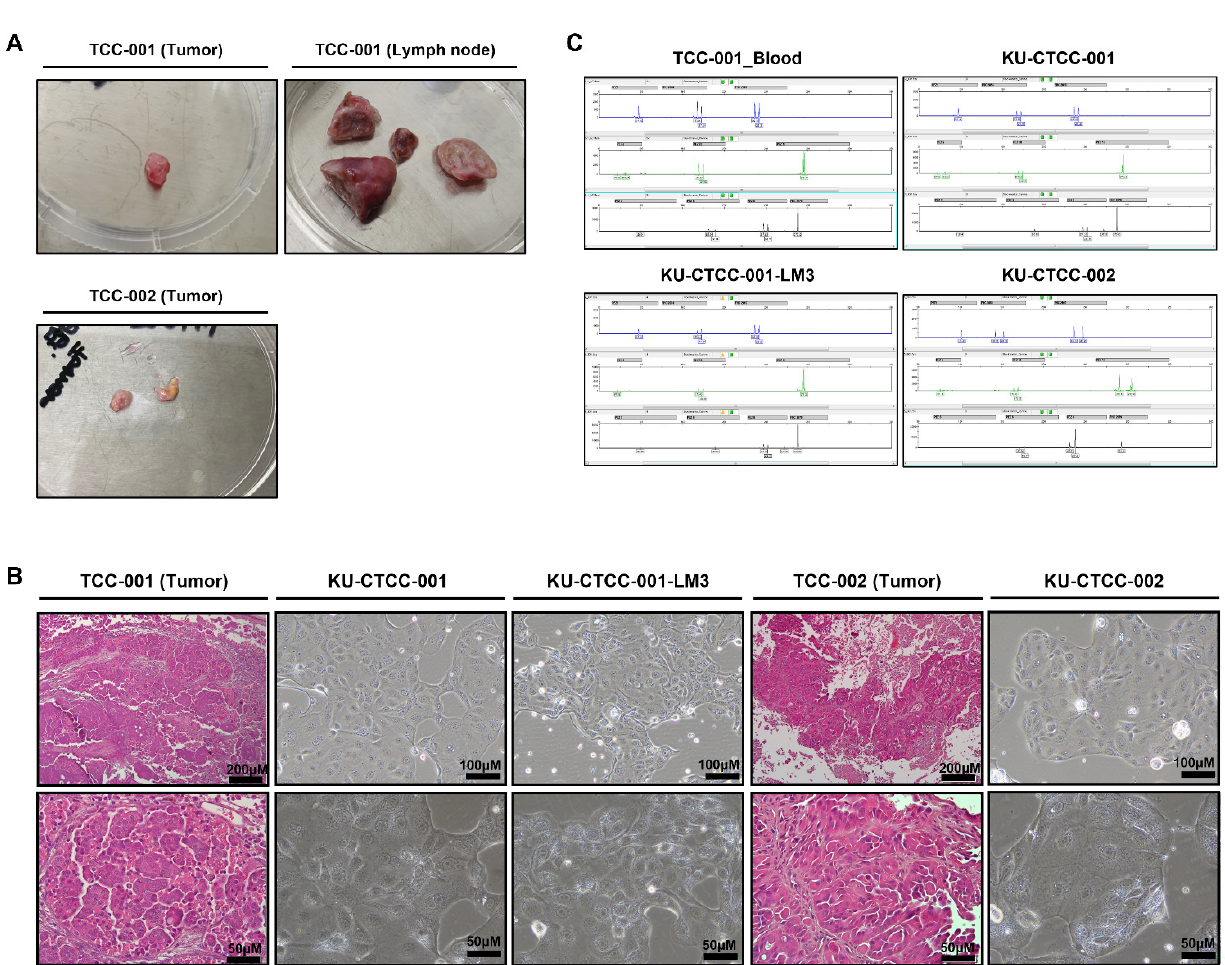
Figure 1. Morphology of original patient tissues and established cell lines. ( A ) Surgically resected tumor tissues collected from canine TCC patients. Tumor tissues were dissociated by mincing and lysed with enzyme. ( B ) Comparison between hematoxylin and eosin (H&E)-stained slides of tumor tissues and cultured cells. All cell lines retained their original morphology. ( C ) Results of STR analysis. The profile showed that KU-CTCC-001 cells and KU-CTCC-001-LM3 cells were derived from the same patient, while KU-CTCC-002 cells were not. They were not contaminated by other sources. TCC-001-Blood represents blood sample derived from patient TCC-001.